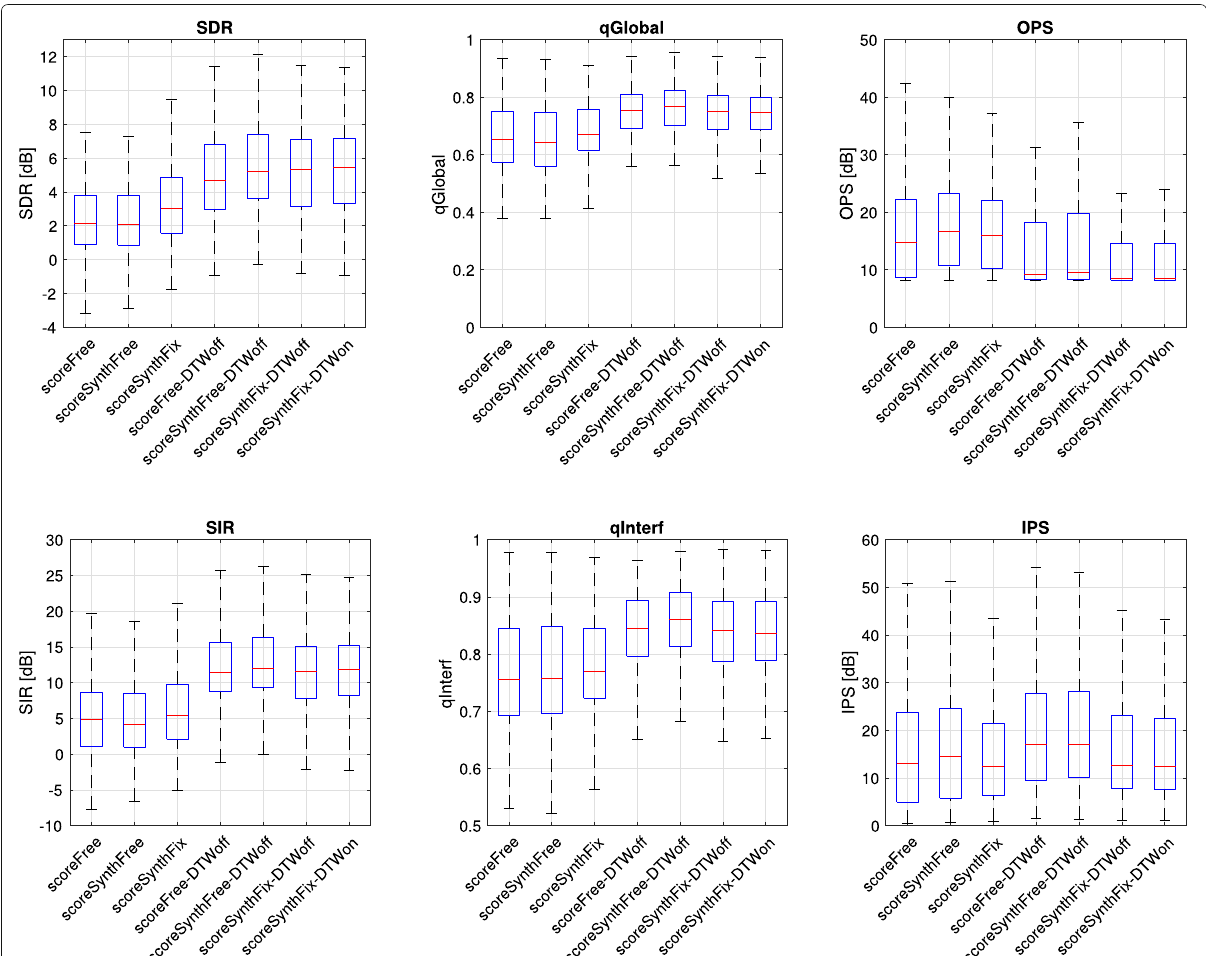
Fig. 6 Objective and perceptual results of the variants of the proposed model using the BBS_EVAL metrics and the PEASS metrics for the URMP